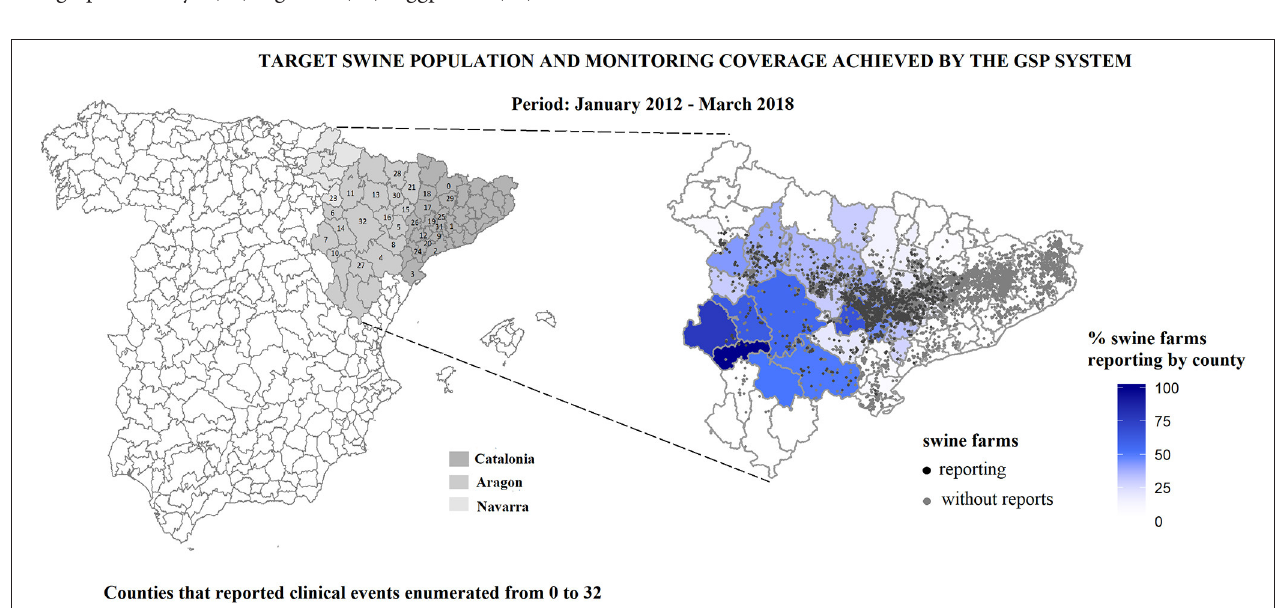
FIGURE 2 | Location of the target swine population and the coverage achieved by the GSP system by county between January, 2012 and March, 2018 in Aragon, Catalonia and Navarra.